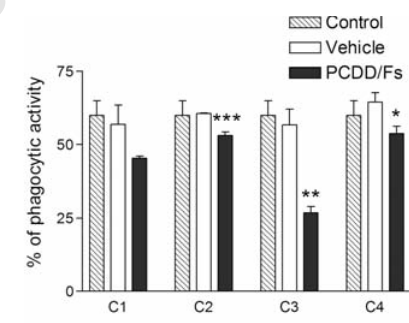
Figure 6. Effects of various concentrations of polychlorinated dibenzo -p- dioxins/ diben- zofurans (PCDDs/Fs) on the phagocytic activity of the extruded cells of E. andrei earthworms. Asterisks represent significant difference compared with vehicle controls (* P<0.05; ** P<0.01; *** P<0.001).